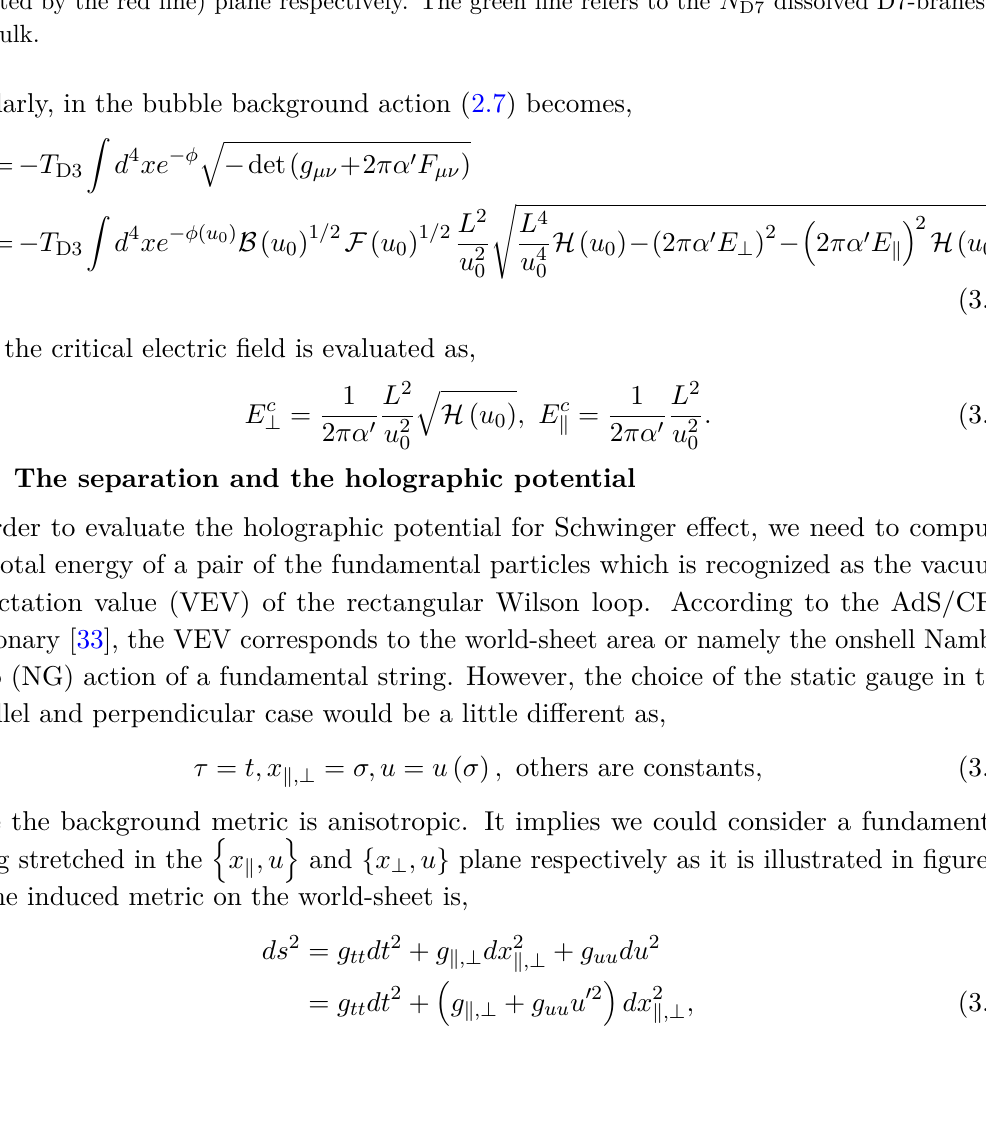
(cid:8) (cid:9) x , u (denoted by the blue line) and { x ⊥ , u } k